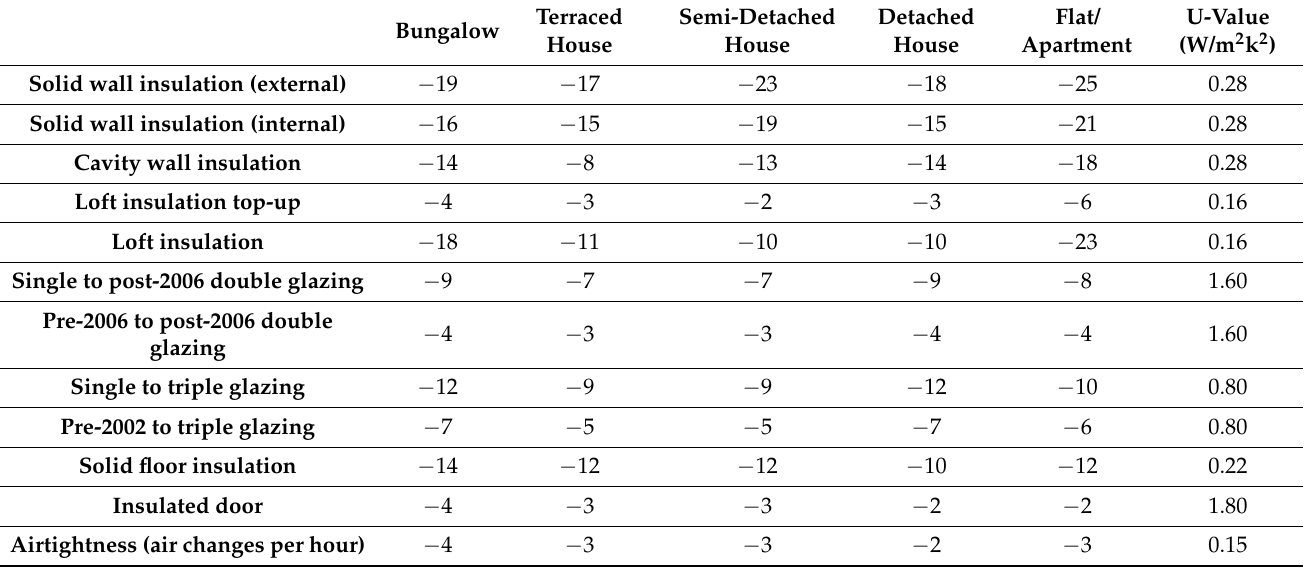
Table A1. Change in demand (kWh/m 2 ) per measure per house type (applicable to Central, High- Level and Passive